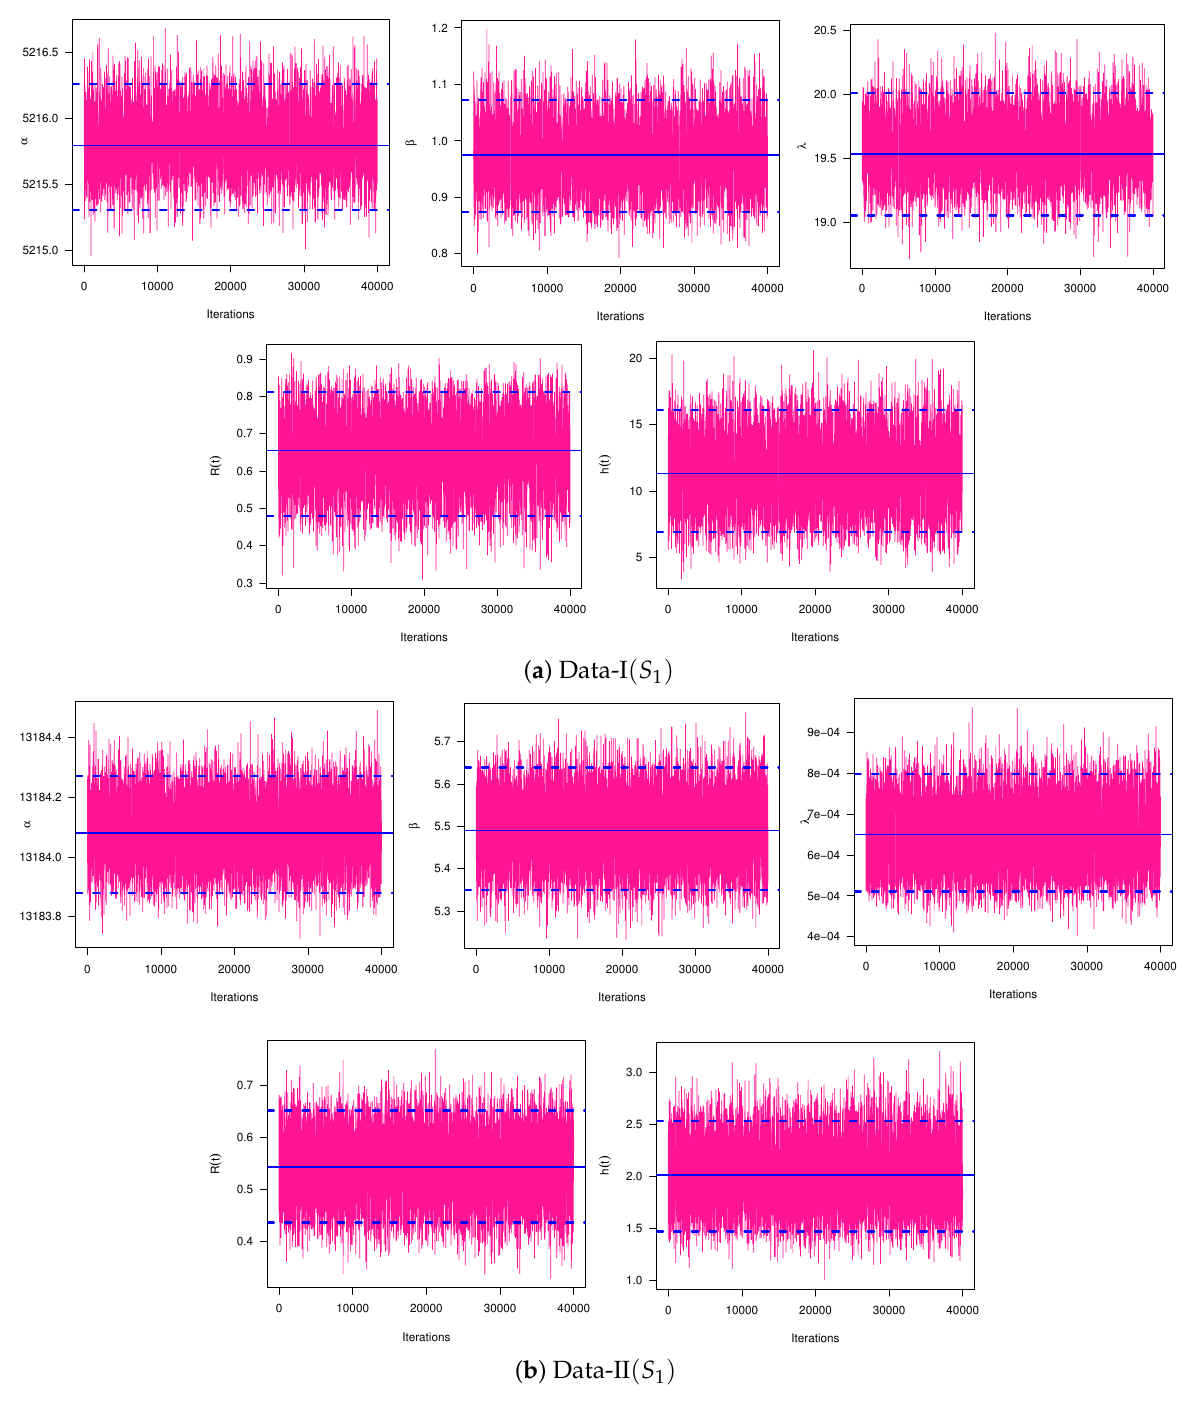
Figure 9. Trace MCMC plots of α , β , λ , R ( t ) and h ( t ) under real data